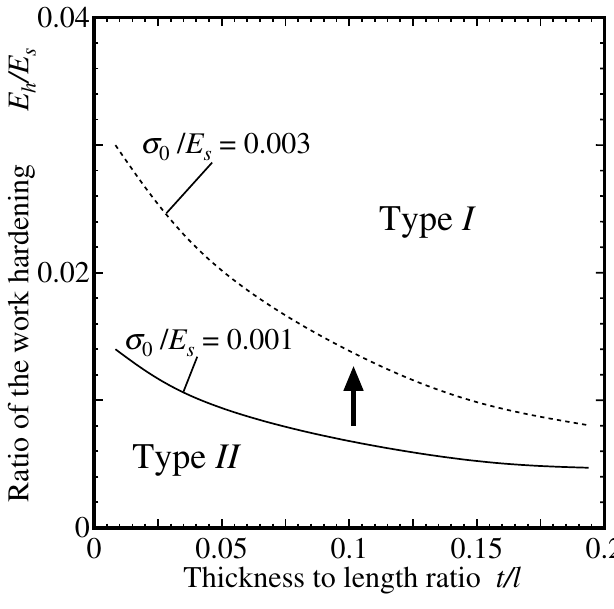
Figure 10. Map for deformation types I and